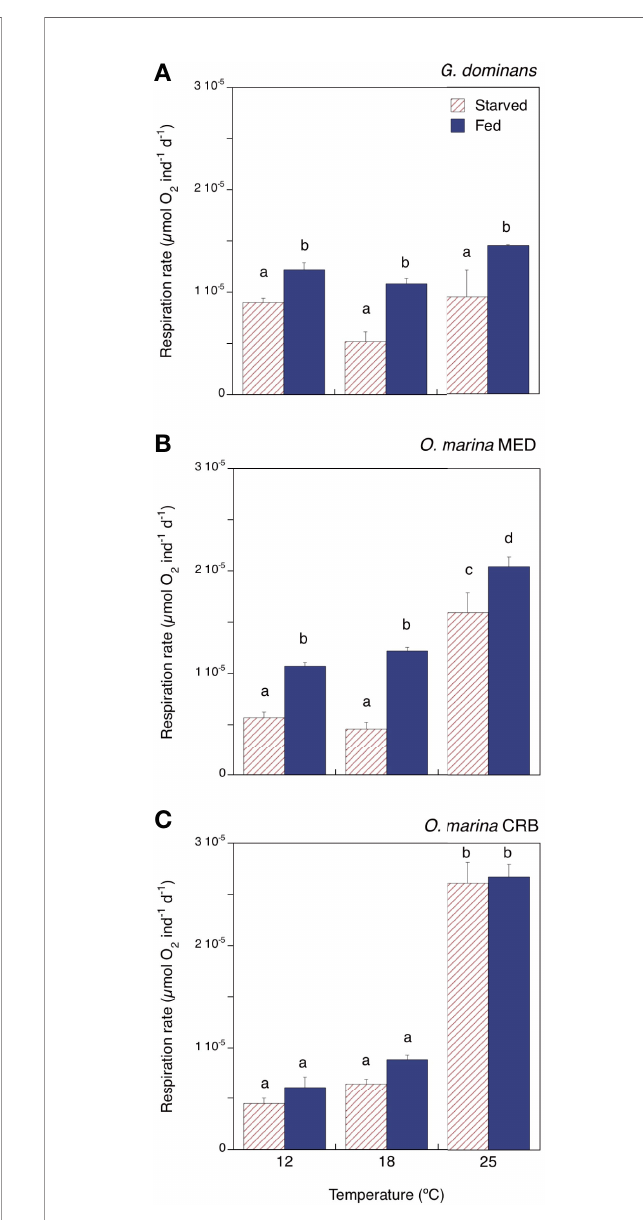
FIGURE 1 | Growth rates ( A , d -1 ), ingestion rates ( B , cells ind -1 d -1 ) and growth gross ef fi ciencies ( C , GGE %) of the three protozoans investigated at 12, 18 and 25°C. Statistical differences (p<0.05) within each species are indicated by different letters. The error bars are SE. For GGE, the SE have been calculated using the square root formula for error propagation.